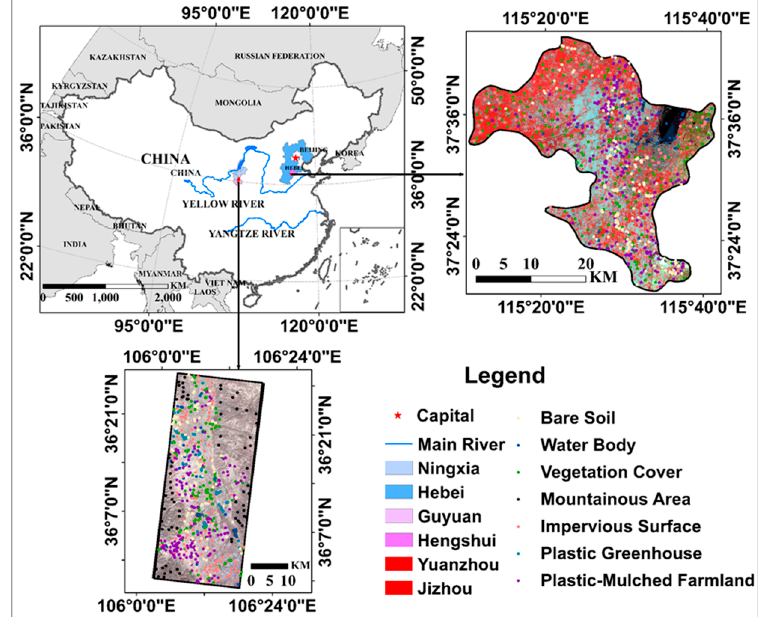
Figure 1. Location of the study area (the imagery displayed in the figure is the GaoFen-1 (GF-1) imagery in false color composite: R = Near Infrared, G = red, B = green).